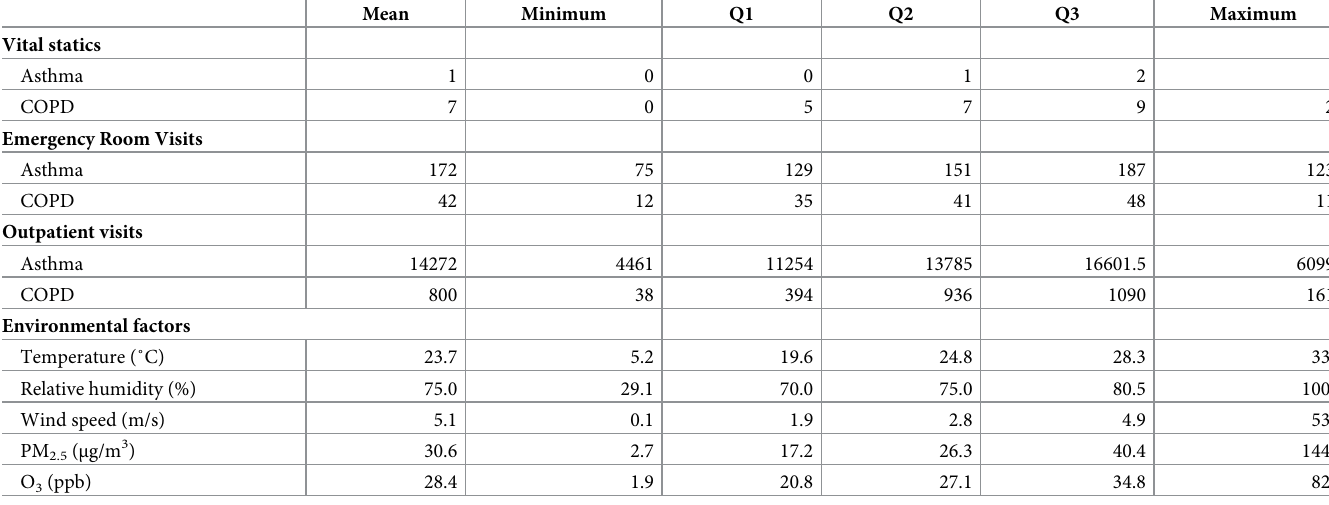
Table 1. Means and ranges of daily cause-specific deaths, ERVs, outpatient visits and ambient environment conditions in six metropolitans in Taiwan from 2005 to 2016.